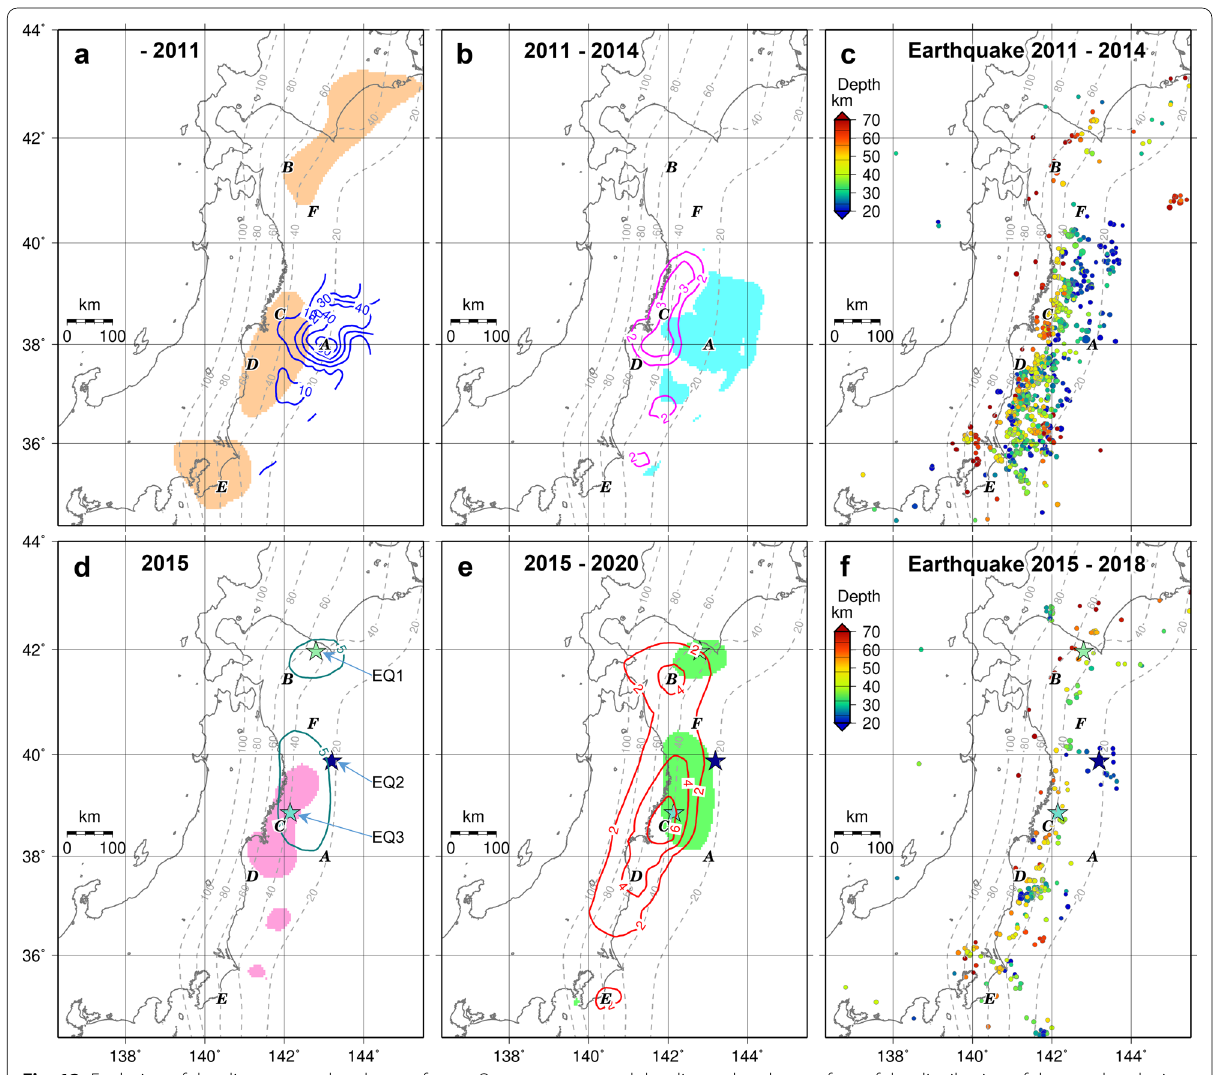
Fig. 13 Evolution of the slip zone on the plate surface. a Orange areas reveal the slip on the plate surface of the distribution of the steady velocity Vt term (> 10 cm/year) (Eqs. 3 and 4) before 2011, and the blue contours depict the coseismic slip of the 2011 Tohoku-Oki earthquake (Ozawa et al. 2012, > 10 m). b Light blue areas indicate the coseismic slip (> 10 m), and pink contours reveal the slip on the plate surface of the short-period logarithmic term (> 2 m) during the three years after the earthquake. c Epicenter distribution map from 2011 to 2014 (including the period when the 2011 Tohoku-Oki earthquake occurred). The depth is 15 km or more, and M > 4.5. d Pink areas depict the slip on the plate surface of the short-period logarithmic term (> 2 m), and green contours represent the gap 2015 (> 5 cm). EQ1, EQ2, and EQ3 indicate epicenter locations of the Urakawa-Oki earthquake (M6.7) on January 14, 2016, the Sanriku-Oki earthquake (M6.9) on February 17, 2015, and the Miyagiken-Oki earthquake (M6.8) on May 13, 2015, respectively. e Green areas depict the gap 2015 (> 5 cm), and red contours reveal the linear deformation (> 2 cm/year) after 2015. Stars represent the EQs described in d . f Epicenter distribution map from 2015 to 2018. The depth is 15 km or more, and M > 4.5. Stars represent the EQs described in d . Areas B to E represent the locations of the characteristic displacement in e . F represents an area with a small displacement in any of the figures, and A represents the location at which the maximum displacement was estimated to have occurred in the main shock of the 2011 Tohoku-Oki earthquake. Isodepth contours of the Pacific slab were estimated by Kita et al. (2010), Nakajima and Hasegawa (2006), and Nakajima et al.